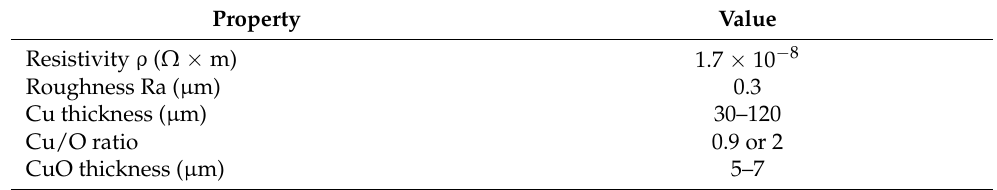
Table 2. Overview of properties of composite Cu x O y + Cu metallizing coatings.